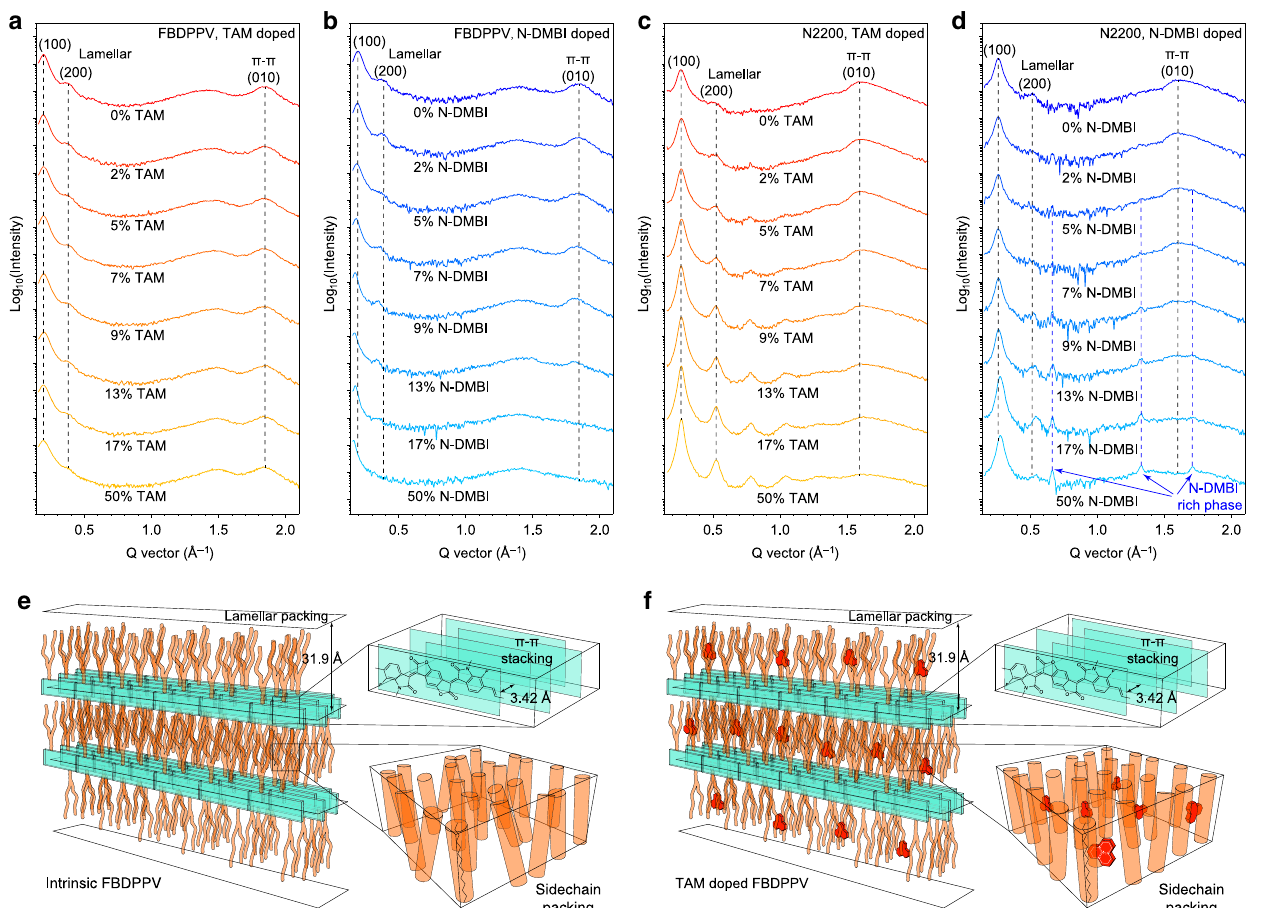
Fig. 5 Solid-state microstructures. a – d Out-of-plane grazing-incidence wide-angle X-ray scattering (GIWAXS) analysis of intrinsic and doped polymers: TAM-doped FBDPPV ( a ), N-DMBI-doped FBDPPV ( b ), TAM-doped N2200 ( c ), and N-DMBI-doped N2200 ( d ). e , f Schematics of the proposed molecular packing models in the intrinsic ( e ) and TAM-doped ( f ) FBDPPV, where light green is for FBDPPV backbone, orange for FBDPPV alkyl side chain, and red for TAM + cation. TAM doping will not affect polymer π – π stacking and lamellar packing, whereas N-DMBI doping can affect both polymer π – π stacking and lamellar packing. TAM is a highly miscible dopant and TAM doping presents “ dopant-at-side-chain ”